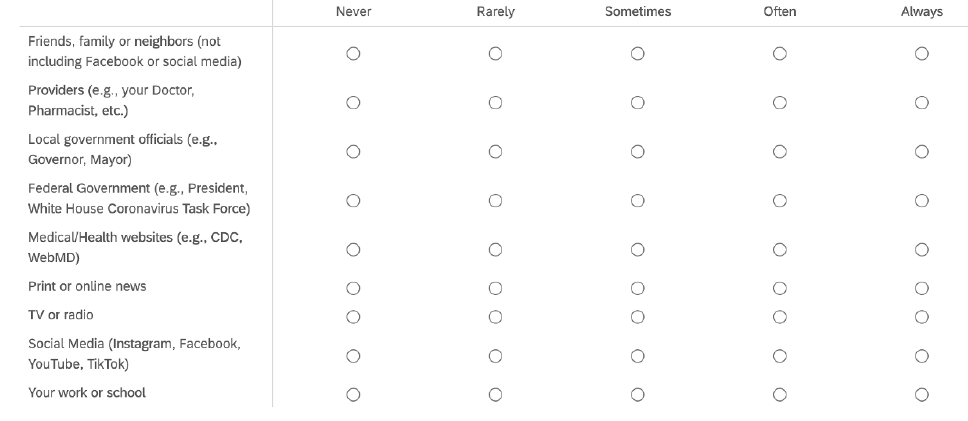
Figure A2. The original question in both of our surveys on consumption